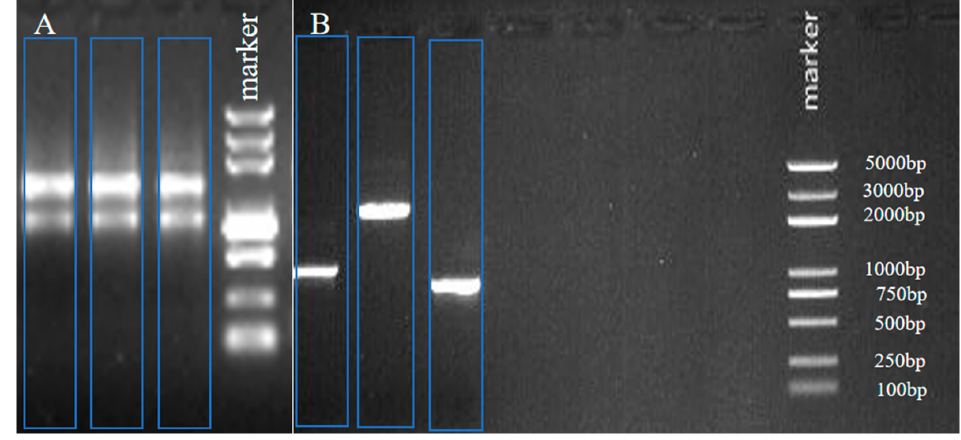
Figure 1. Agarose gel electrophoresis of total RNA ( A ), PCR products of 3 ′ or 5 ′ RACE ( B ). Through SMART TM RACE cDNA amplification, the full-length cDNA sequence of chiti- nase was isolated from mangrove and named BgCHI III (Figure 2A), KoCHI III (Figure 2B),